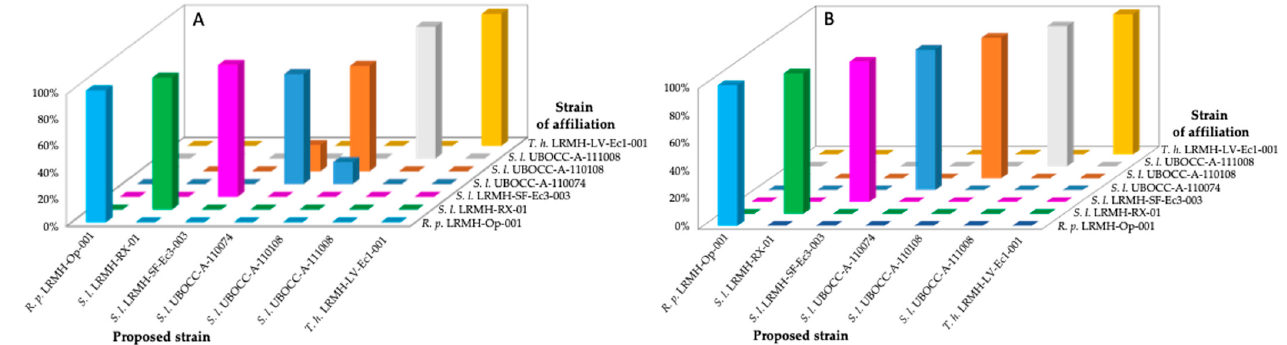
Figure 4. Confusion matrix obtained for the discrimination of the strains after growth on the PES membrane, and direct analysis on the membrane. Min–max normalization (A), Vector normalization (B). R. p. , Rhodonia placenta . S. l. , Serpula